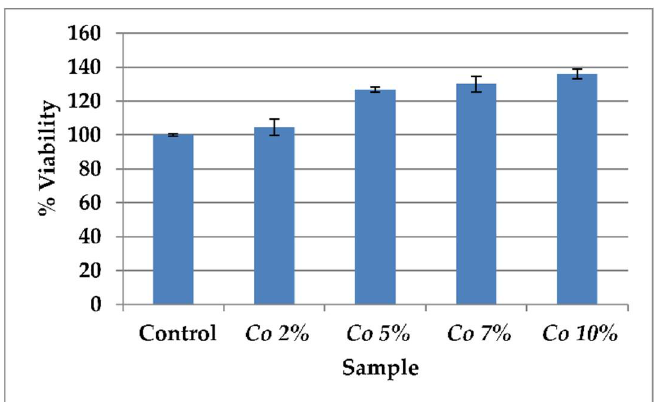
Figure 1. Percentage of cell viability at various concentrations of Calendula officinalis oil.